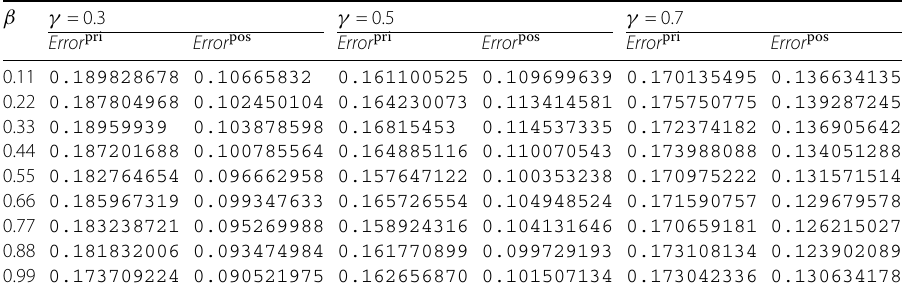
Table 2 The error between the regularized solutions and the sought solution at ε = 0.034 β γ = 0.3 γ = 0.5 γ =